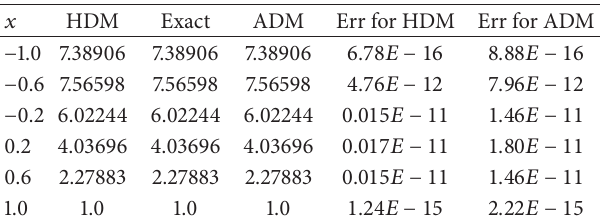
Table 2: Comparison of the HDM and [1] results with the exaction solution for 𝑁 = 6